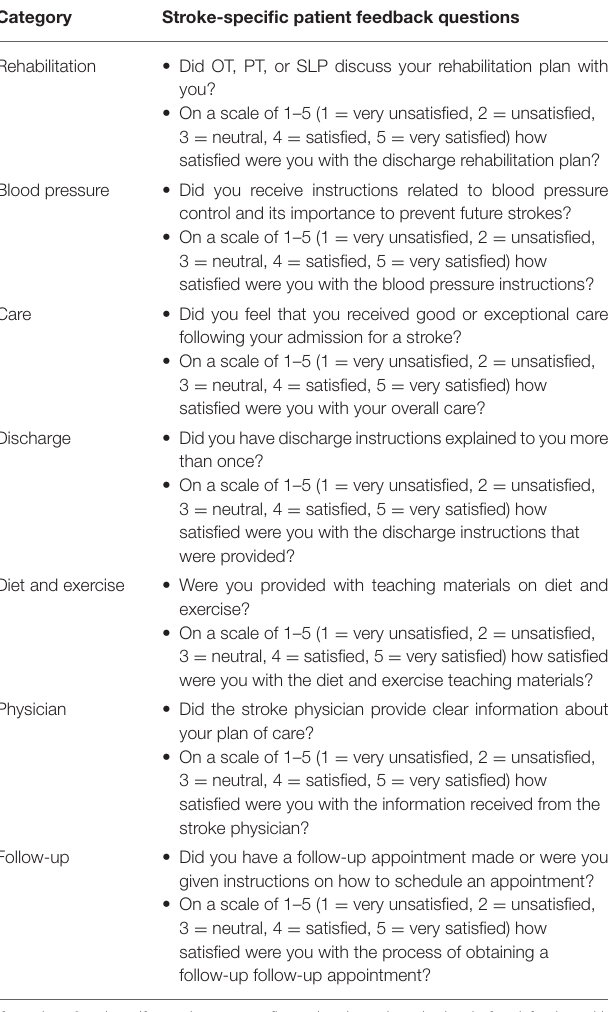
TABLE 1 | Patient satisfaction